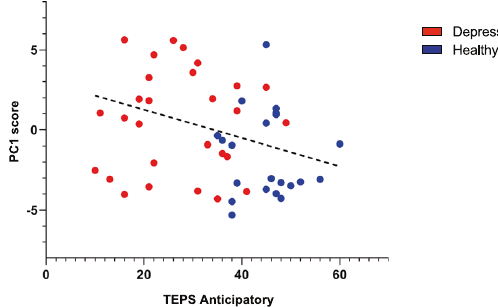
Fig. 2 Peripheral blood mononuclear cells reactivity is negatively associated with response to pleasure. Negative correlation between immune factors released by peripheral blood mononuclear cells (PBMCs) stimulated ex vivo with lipopolysaccharide (LPS) represented by factor loading on PC1 and anticipatory reward, as measured with the anticipation subscale of the TEPS PC1 against whole-brain activation to gain > neutral cue revealed no signi fi cant correlation between brain activation and PC1.